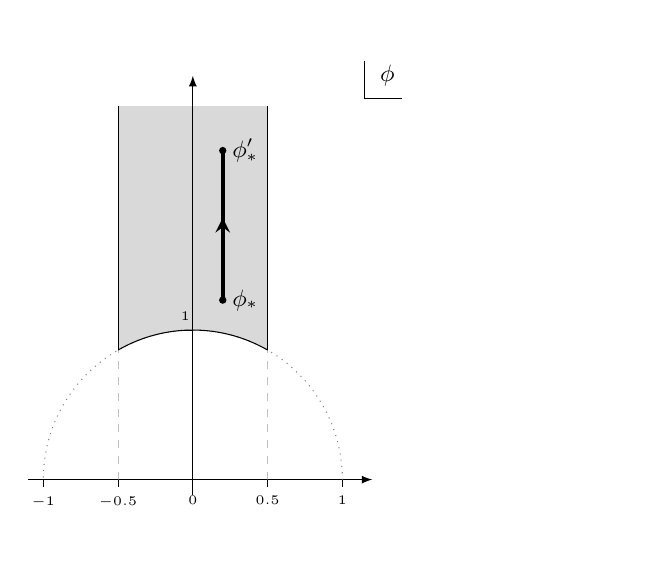
Figure 2 . The fundamental domain of (cid:30) . Along the domain wall, (cid:30) (cid:13)ows up along the vertical line speci(cid:12)ed by Re (cid:30) (cid:3)